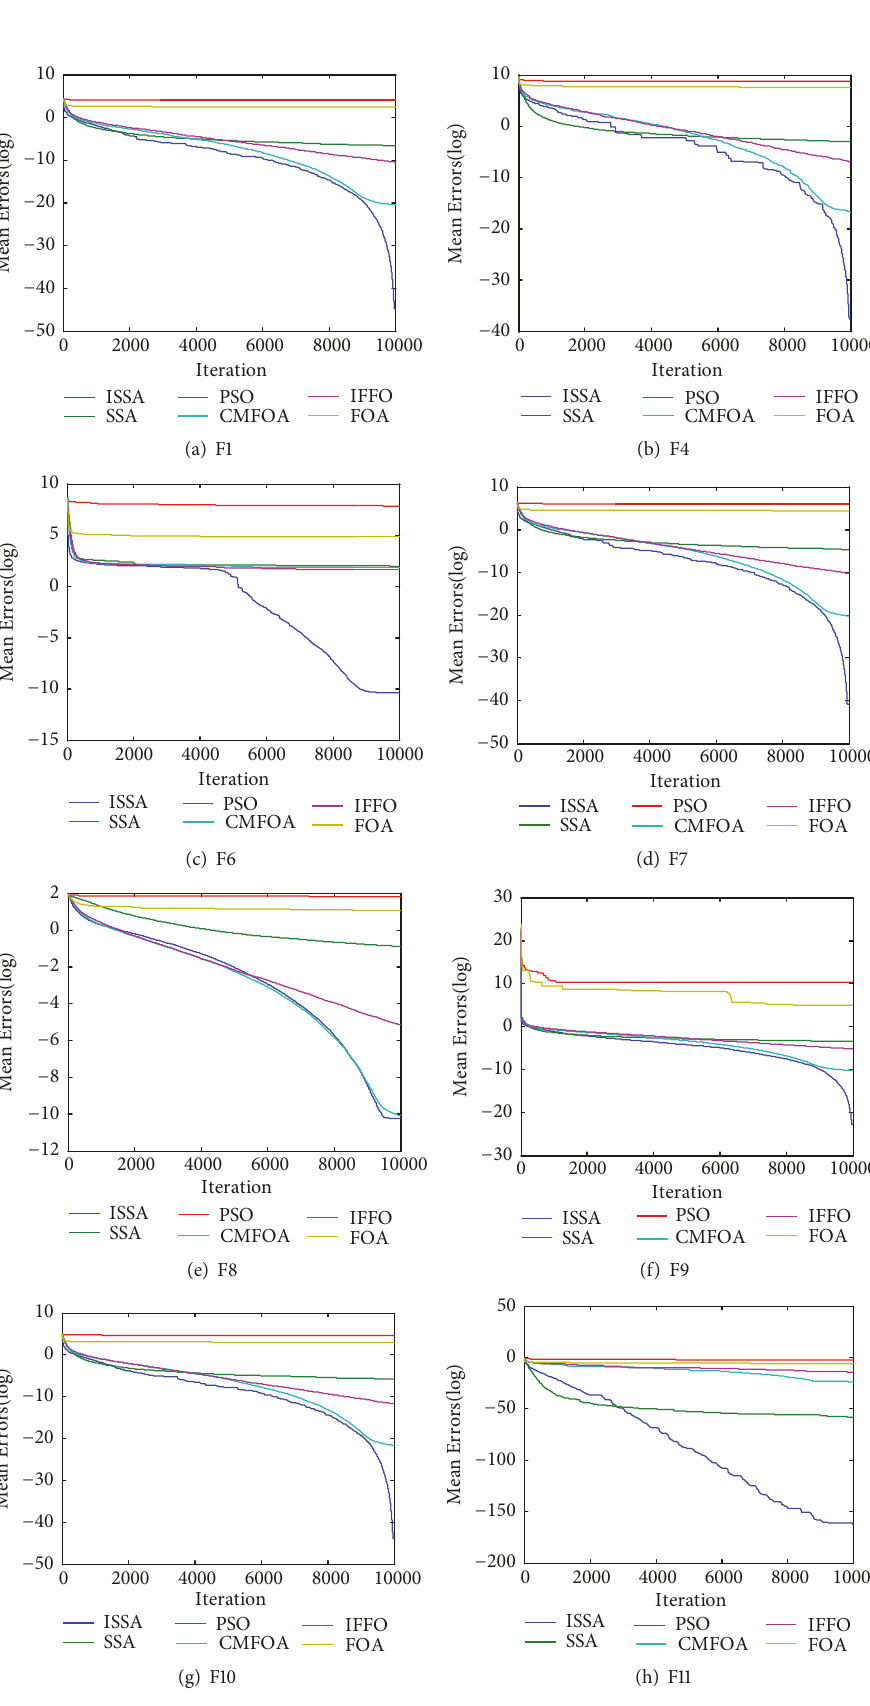
Figure 2: Convergence rate comparison for representative unimodal functions ( n =